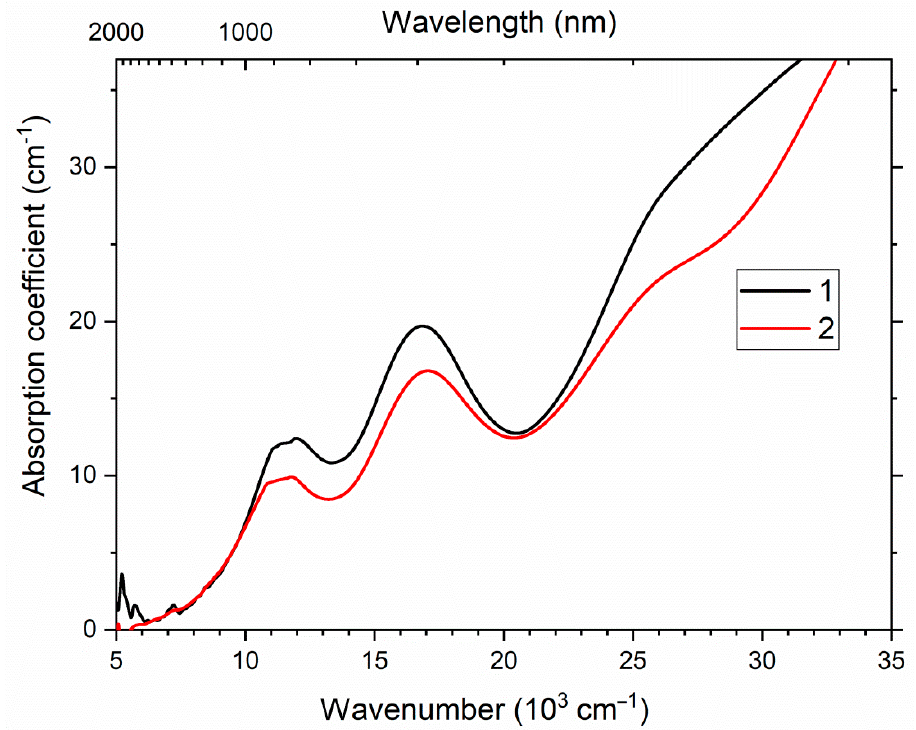
Figure 13. UV–Vis–near IR absorption spectra of afghanite Samples 9 (curve 1) and 10 (curve 2). The ESR spectra of the afghanite Samples 9 and 10 at room temperature show a weak signal and a poor-resolved band with a g factor of about 2.032. The signal intensity is three orders of magnitude lower than in the ESR spectrum of lazurite [6]. When the samples were cooled to a temperature of 77 K, the signal intensity increased (Figure 14), and its structure became better resolved, with the components g x = 2.002, g y = 2.060 and g z = 2.038 for Sample 9 and g x = 2.002, g y = 2.057 and g z = 2.035 for Sample 10.